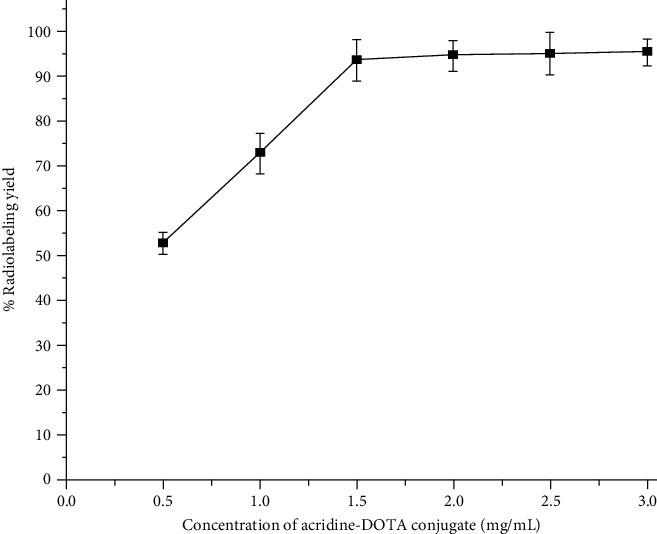
Variation of % radiolabeling yield of 177Lu-acridine complex with ligand concentration.